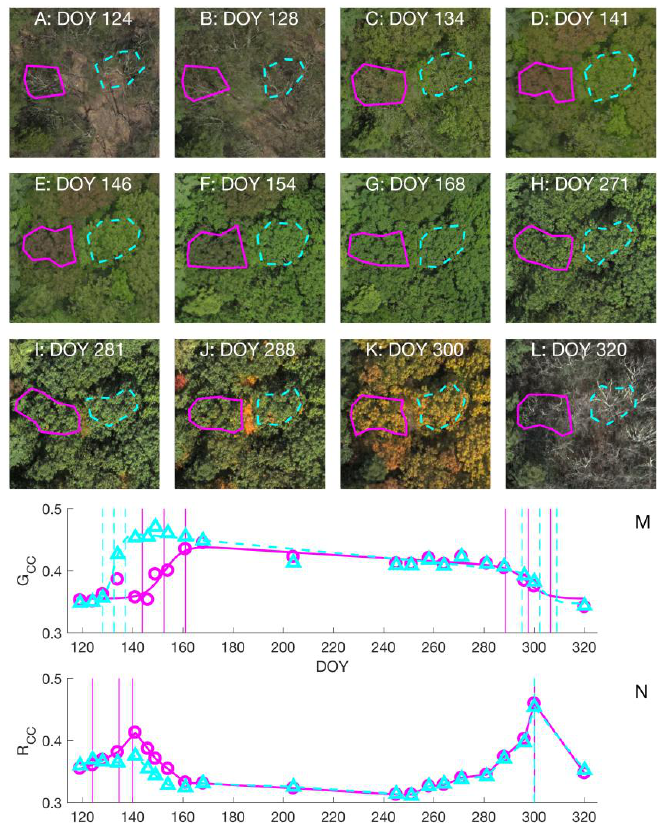
Figure 2. ( A – L ): Close-up (30 m by 30 m) of aerial images for a selection of dates from 2015. Each close-up shows the ROIs used to analyze two red oak trees. Solid magenta ROIs were used to calculate solid magenta G CC and R CC values (circles symbols) and curves; similar with the dashed cyan ROIs (triangle symbols.). Images have been equalized to have the same brightness (sum of R, G, and B digital numbers) for visualization purposes in this figure; ( M , N ): the resulting G CC and R CC time series (symbols); curve fits or interpolations; and estimated phenophase transition dates (vertical lines). The vertical lines show six annual dates for both G CC time series, while spring dates calculated from R CC series are only shown for the tree with red spring leaves. R CC -EOF occurred on the same date for both trees.